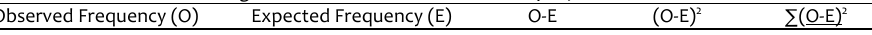
Figure 10: Calculation of chi ‐ square for the Reponses on classroom management and students’ academic